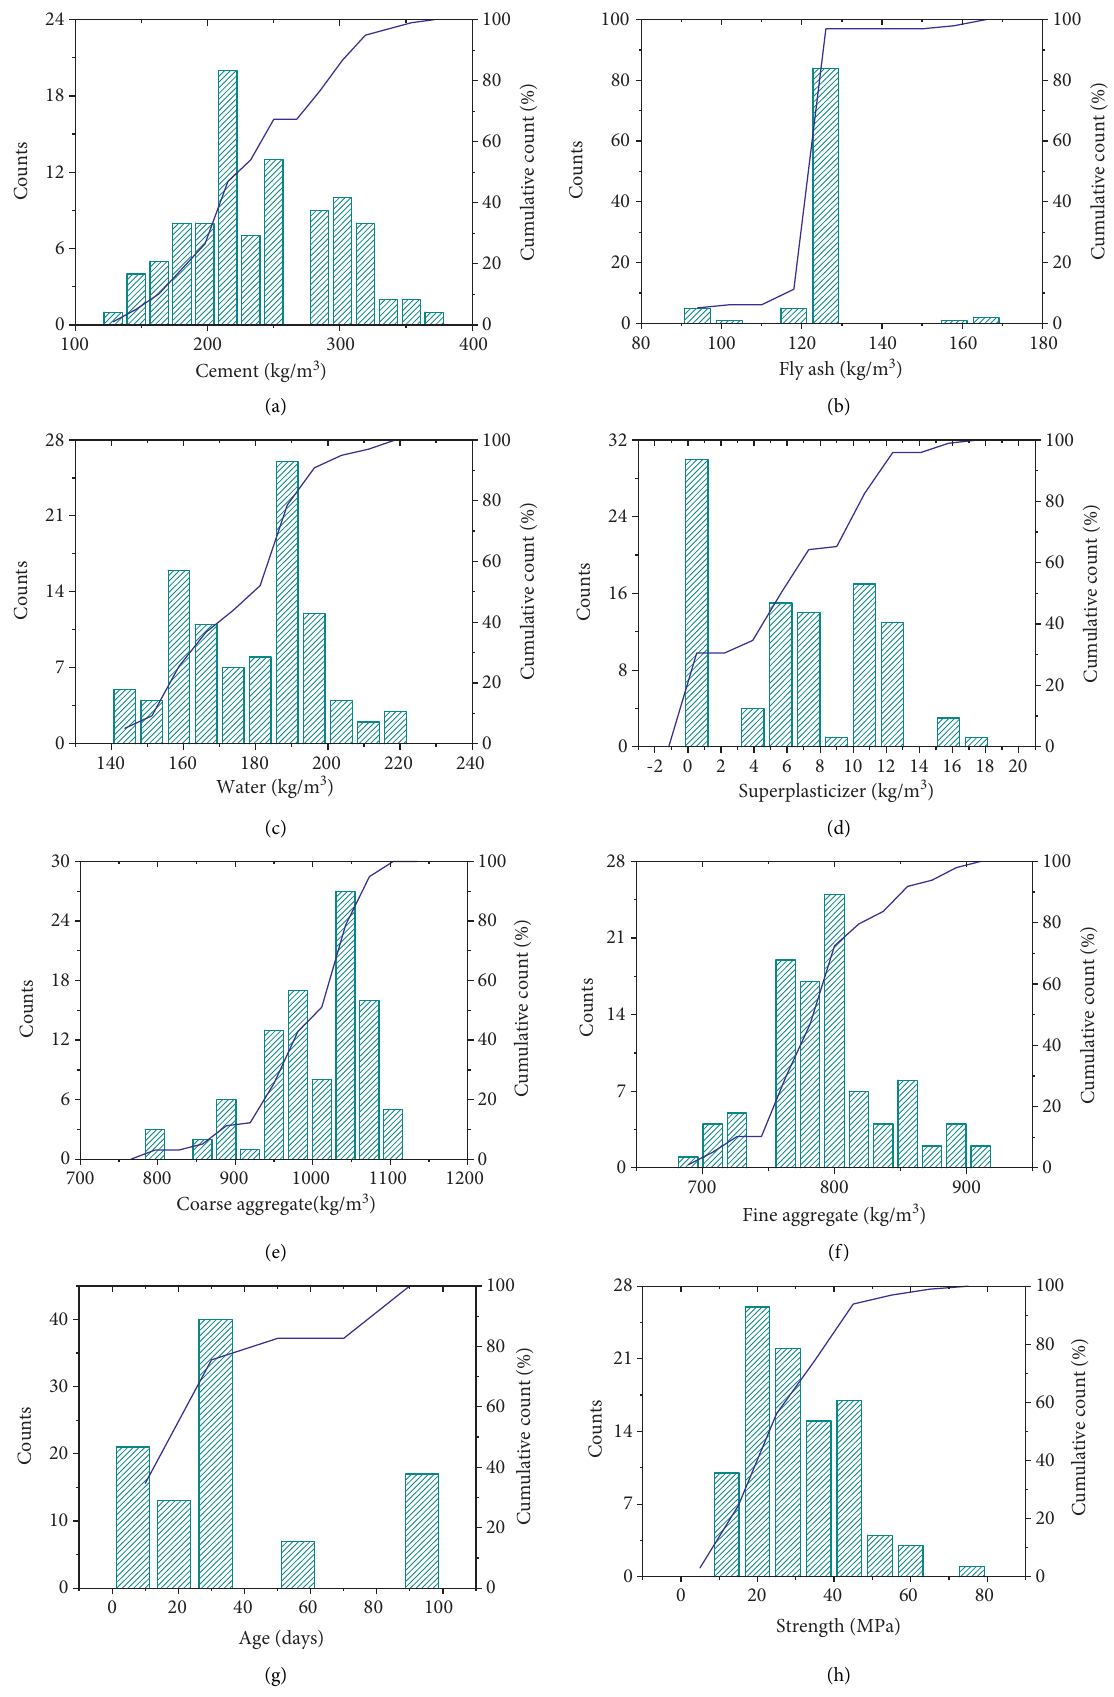
Figure 3: Distribution of input and output